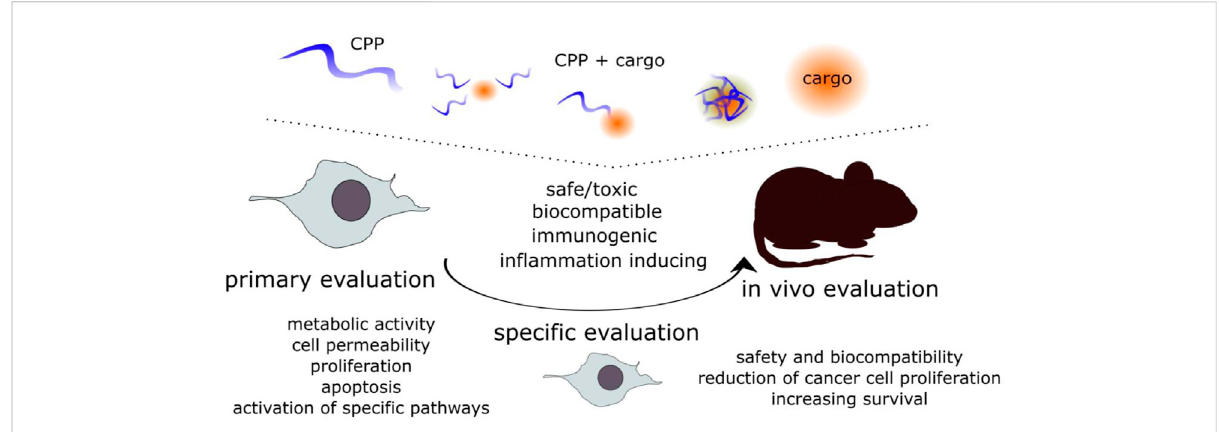
FIGURE 3 The evaluation of the safety, biocompatibility and bioeffect of the CPP-cargo. The CPP, the cargo and the CPP-cargo associations should be evaluated at each step. The initial primary evaluation is done with more general approaches, and after con fi rming the safe or effective doses more speci fi c approaches can be used to determine effects on different aspects, such as reduction of cell proliferation, increase of membrane permeability,cellcyclearrest, etc. Thesearealsorequiredforfurtherevaluation invivo tocon fi rmsafetyoftheCPP-cargooriftheCPP-cargois able to reduce the proliferation of cancer cells and increase